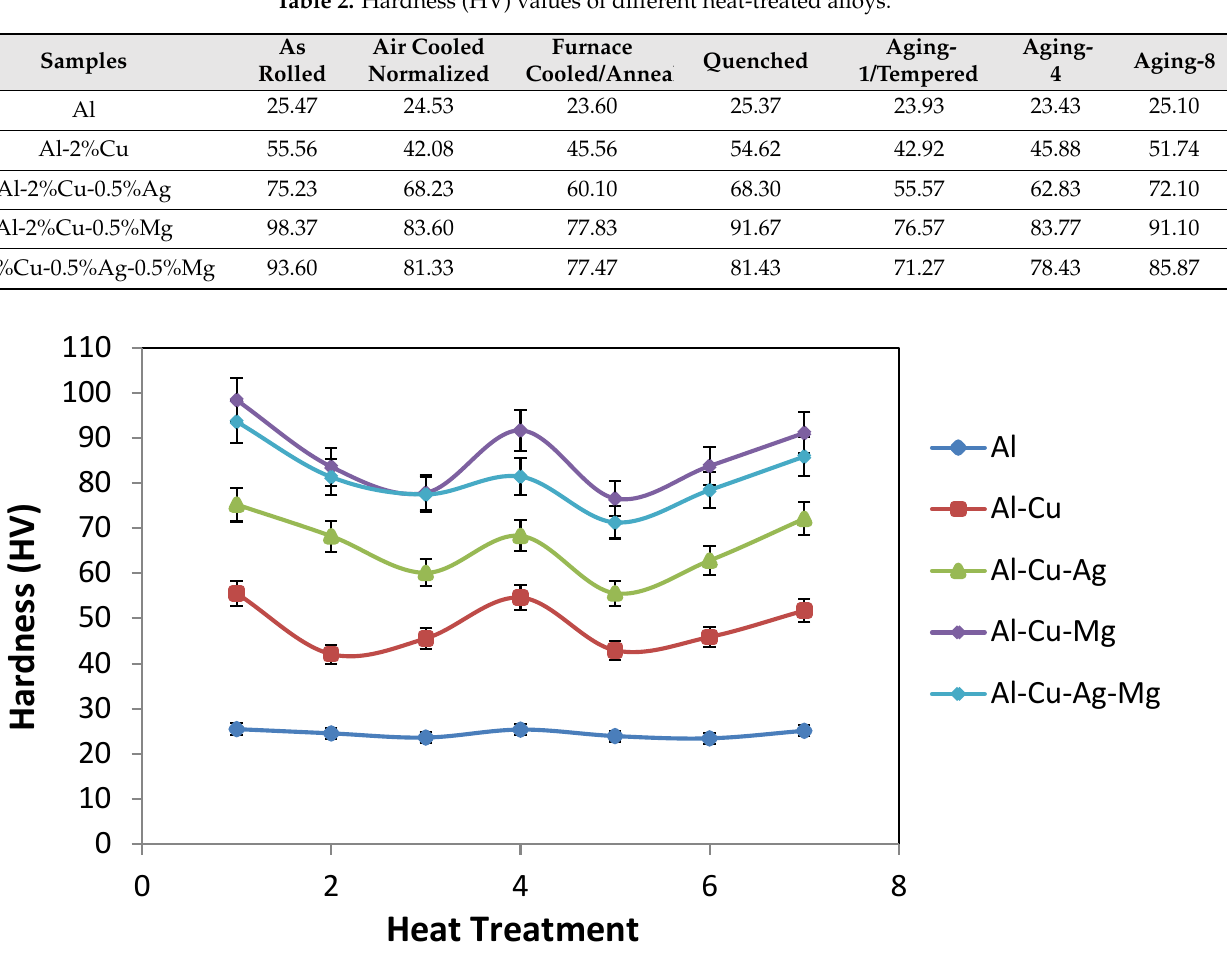
Figure 3. Variation of micro-hardness (HV) with heat treatment of different alloys.